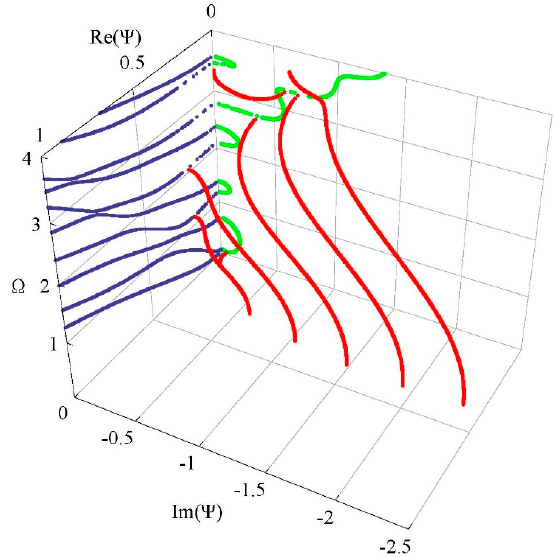
Figure 8. Frequency spectrum of a Lamb-like wave in a FGM spherical curved plate.